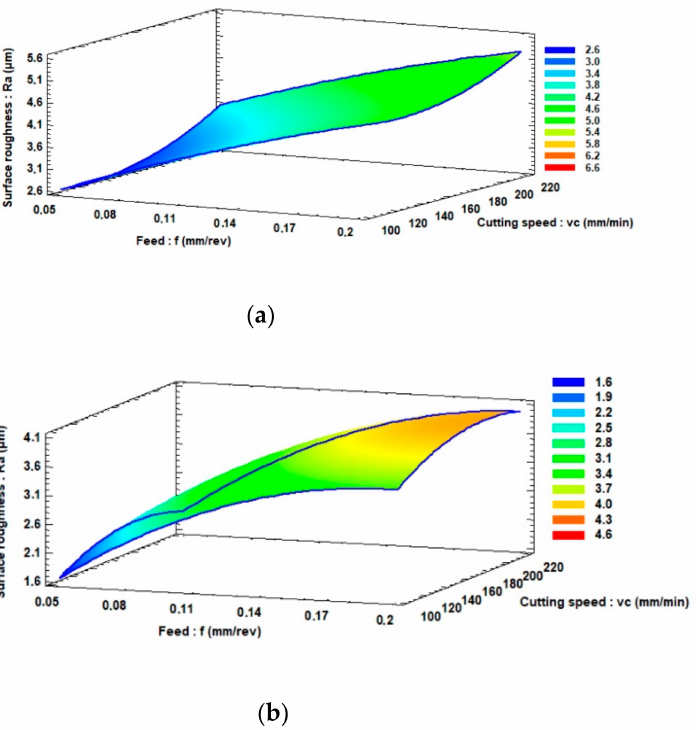
Figure 4. Response surface as a function of feed rate and cutting speed during dry machining ( a ) 6061 R alloy and ( b ) 6061R-T6 alloy.